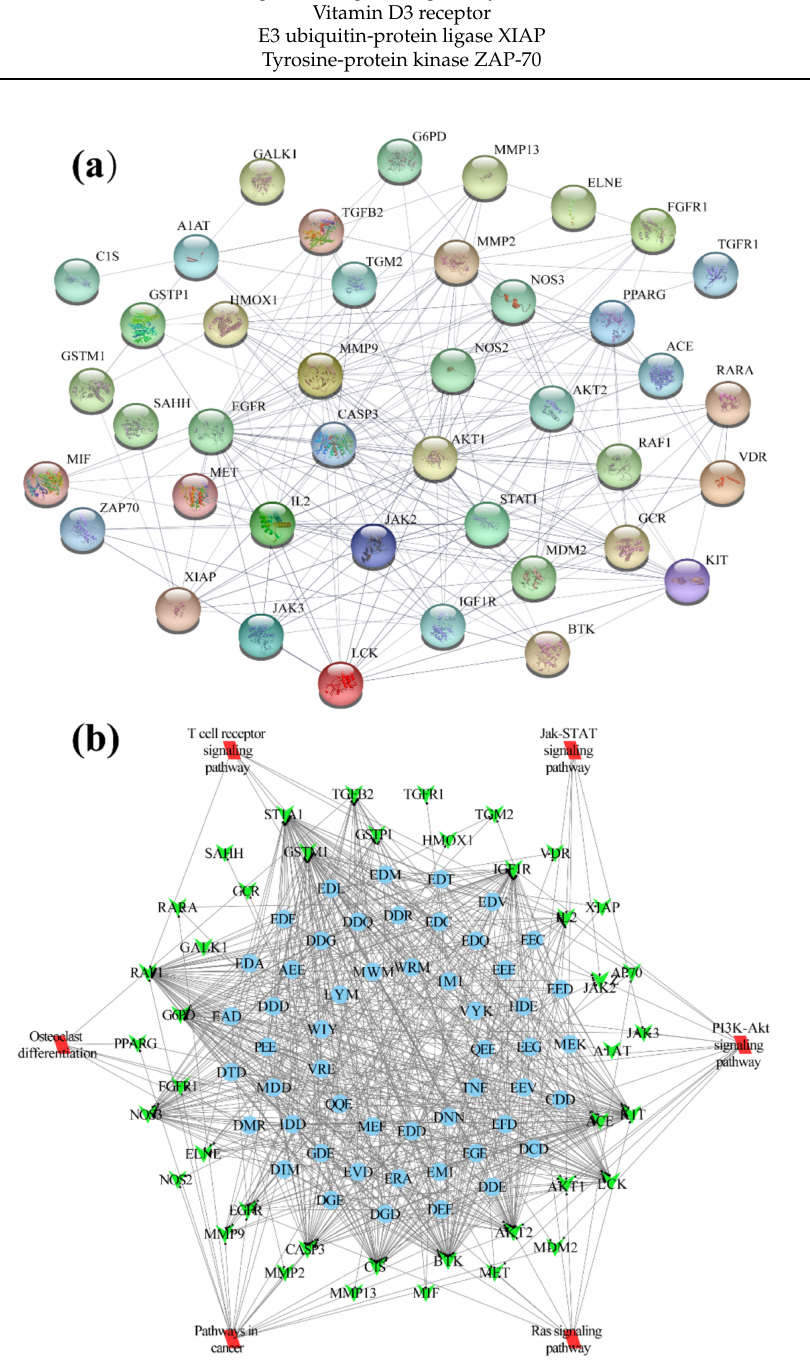
Figure 1. Protein-protein interaction network ( a ) and tripeptides-targets-pathway interaction network diagram ( b ). The green nodes in ( b ) represent the hub targets, the blue nodes represent the tripeptides, and the red nodes stand for the significant signaling